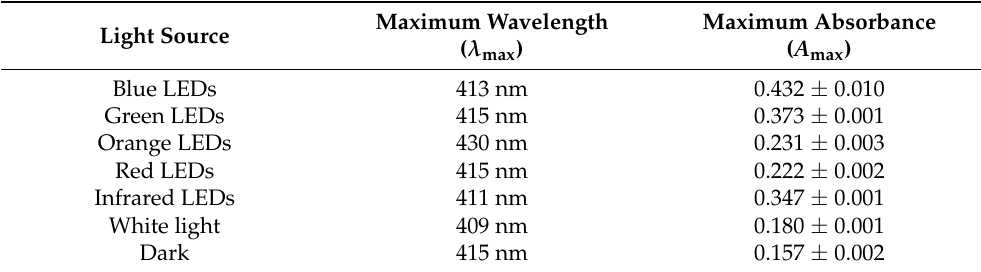
Table 1. The maximum wavelength ( λ max ) and maximum absorbance ( A max ) after 24 h during T. purpurogenus extracellular-pigment-mediated AgNPs biosynthesis by light exposure at different